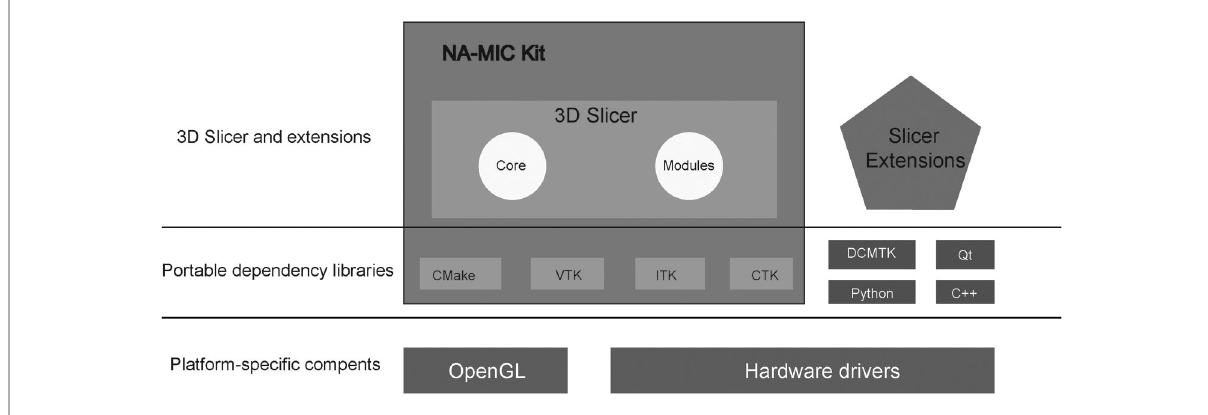
FIGURE 3 3D slicer ecosystem. 3D Slicer consists of the lean application core, Slicer Modules, and Slicer Extensions. Languages (primarily C++, Python, and JavaScript) and library (Qt) provide higher-level functionality and abstractions. NA-MIC Kit components provide the tools and interfaces for the needs of the developers of medical image computing applications. CMake enables cross-platform build system con fi guration, packaging, testing of 3D Slicer and NA-MIC Kit libraries. VTK (Visualization Toolkit) provides the key building blocks for 3D computer graphics and visualization. ITK (The Insight Toolkit) is a library developed speci fi cally for the tasks related to medical image registration and segmentation, and for implementing new image analysis algorithms. CTK (Common Toolkit) is a biomedical image computing library with a focus on application-level DICOM support, plugin framework, and specialized GUI